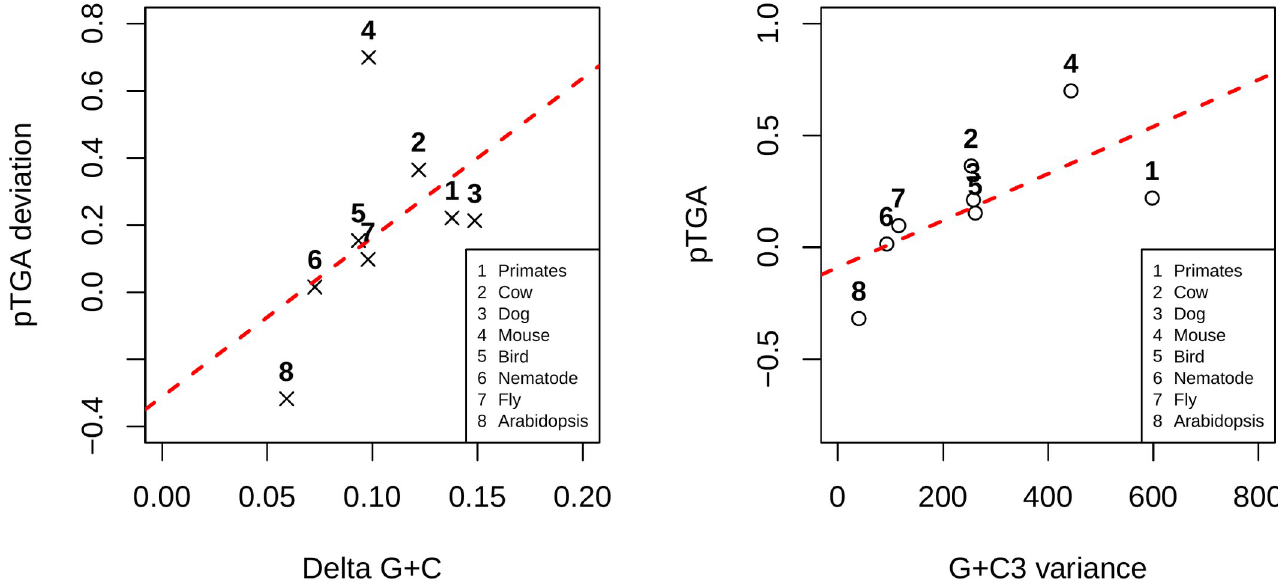
Fig 3. pTGA deviation between the top 50% and bottom 50% of genes by GC content as a function of (a) the difference in GC content between the 2 gene bins, “delta GC,” and (b) coding sequence GC3 content variance across a sample of 4 mammalian and 4 nonmammalian lineages. pTGA is calculated as 1/(1 +(TGA ! TAA/TAA ! TGA)) and hence represents the balance between the 2 dominant stop codon flux events. pTGA deviation is calculated as (O-E)/E where O is the pTGA score of GC-rich genes and E is the pTGA score of GC-poor genes. pTGA deviation is positively correlated with both delta GC (Spearman’s rank; p = 0.046, rho = 0.74, n = 8) and GC3 variance (Spearman’s rank; p = 0.028, rho = 0.79, n = 8). Underlying data can be found in S3 Data. (O-E)/E, (Observed- Expected)/Expected; pTGA, predicted TGA